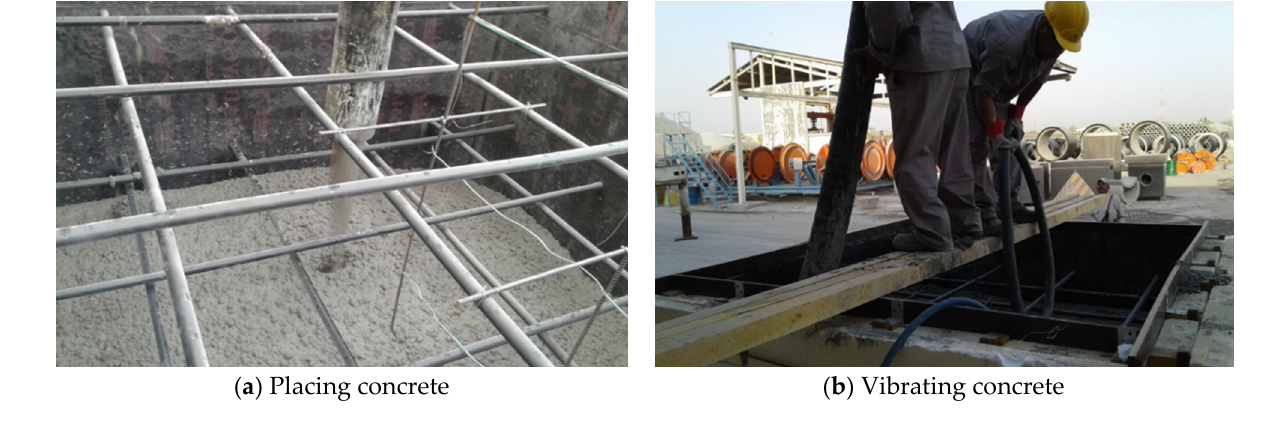
Figure 14. Placing and vibrating of concrete. Table 15. Test result of fresh concrete produced from batch plant.